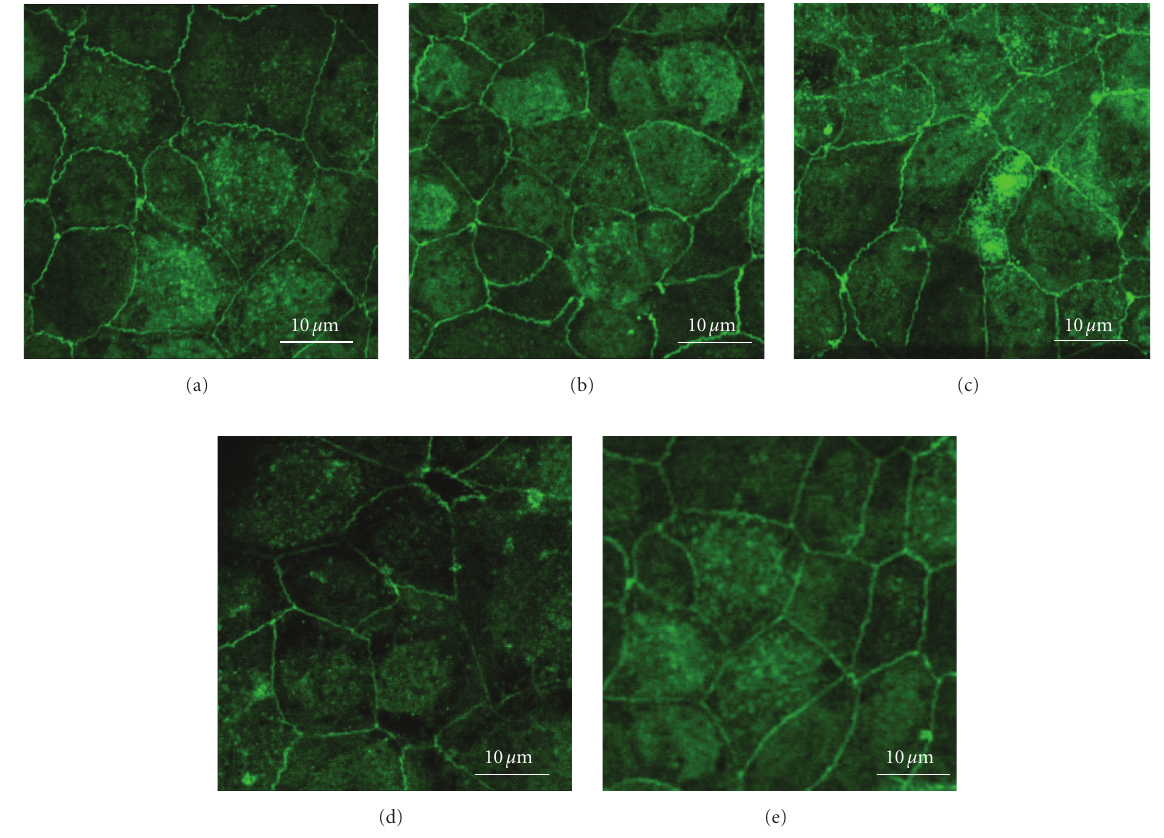
Figure 7: E ff ect of PEI/LV vectors and free PEI on occludin localization . Polarized 16HBE41o- cells were incubated with free 1 × 10 7 PEI molecules (e) or PEI/LV vectors formulated at ratios of 5 × 10 4 (b), 1 × 10 6 (c), and 1 × 10 7 (d) with 50 MOI LV for 24 hours and then evaluated for occludin localization by confocal microscopy. Mock (a) is represented by cells incubated with medium only. Note in green the circumferential localization of occludin between cells, with some intracellular staining. En-face micrographs are shown. Bar: 10 μ